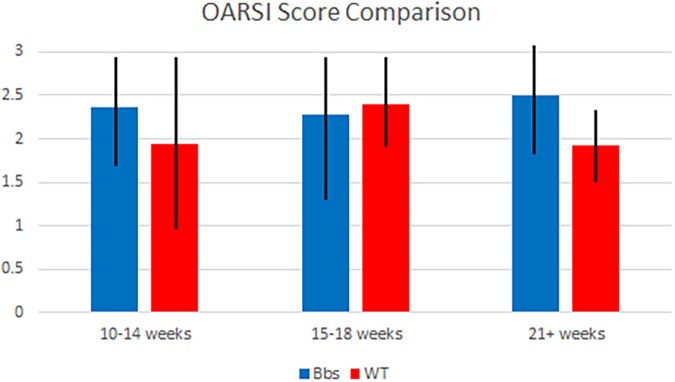
OARSI score comparison of Bbs1M390R/M390R mutant and WT mice at various ages. Articular cartilage degradation from both mutant and WT samples was objectively evaluated using the OARSI scoring system by two blind scorers. Samples were combined into generalized age groups of 10–14 (WT n = 8; Bbs1M390R/M390R mutant n = 18), 15–18 (WT n = 24; Bbs1M390R/M390R mutant n = 39) and 21+ (WT n = 12; Bbs1M390R/M390R mutant n = 4) weeks. Mean OARSI scores of 2.25, 2.2, and 2.5 (10–14, 15–18, 21+ weeks, respectively) were not significantly different than those of WT mice.